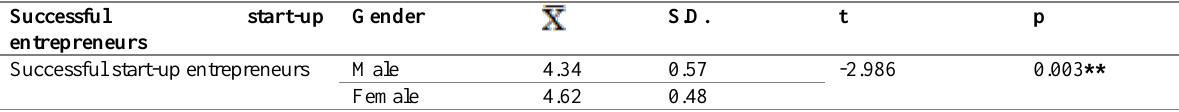
* Statistically significant differences at 0.01 level The table showed that successful start-up entrepreneurs with different gender had statistically significant differences at 0.01 (p= 0.003). Table 6: Comparison of desired characteristics of successful start-up entrepreneurs in Prachuap Kirikhan province according to Age, Educational background, Investment, Business capital, Entrepreneur experience and Number of